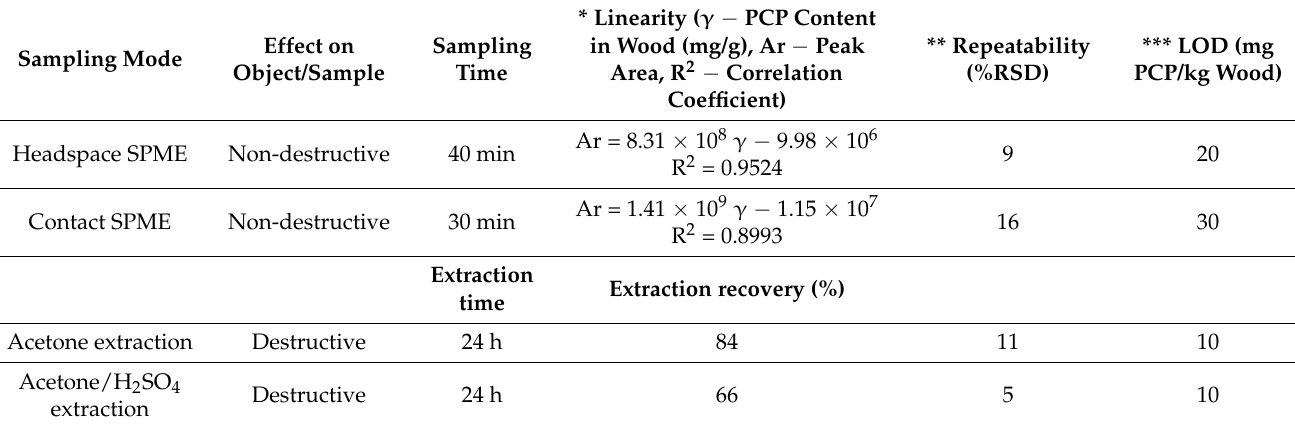
Table 1. Comparison of sampling/extraction methods for PCP in